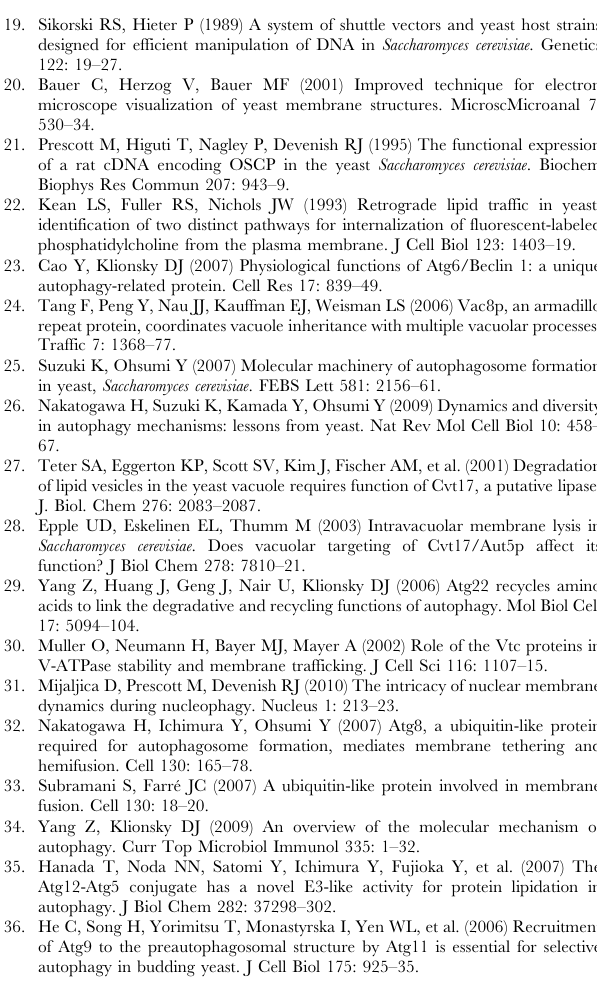
Figure S5 Wild type (BY4741), atg3 D and atg11 D cells were grown in SS + D or SD-N medium for 24 hours. Loss of plasma membrane integrity (indication of dead cells) was indicated by PI staining. Cells were incubated with 5 m g/ml of PI for 10 min at room